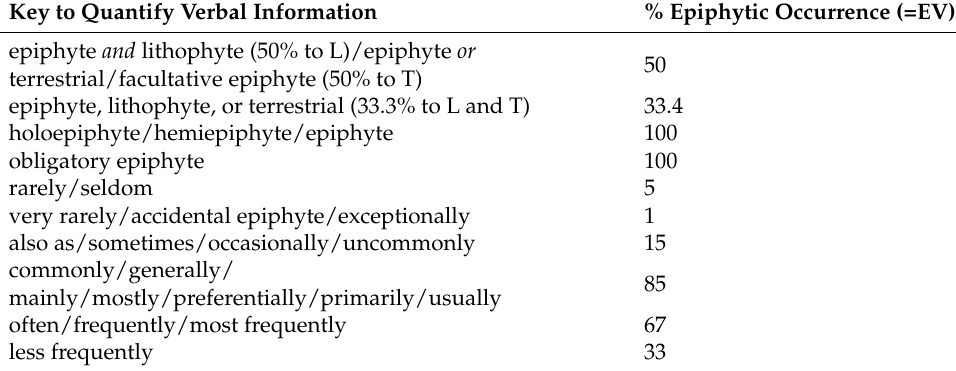
Table 1. Numerical translation of literal descriptions of species occurrences in the original sources as epiphytes, lithophytes or terrestrials. Special cases: with explicit information on life form of specimens we used the proportions, e.g., [28]; “on rotten logs” or “dead wood” counts as “terrestrial” Trichomanes accedens in [29], while “epiphytic and on fallen logs” counts as “epiphytic” assuming plants were already on the tree before the fall. We acknowledge that this may obscure possible preferences for rotting logs as growing sites, e.g.,